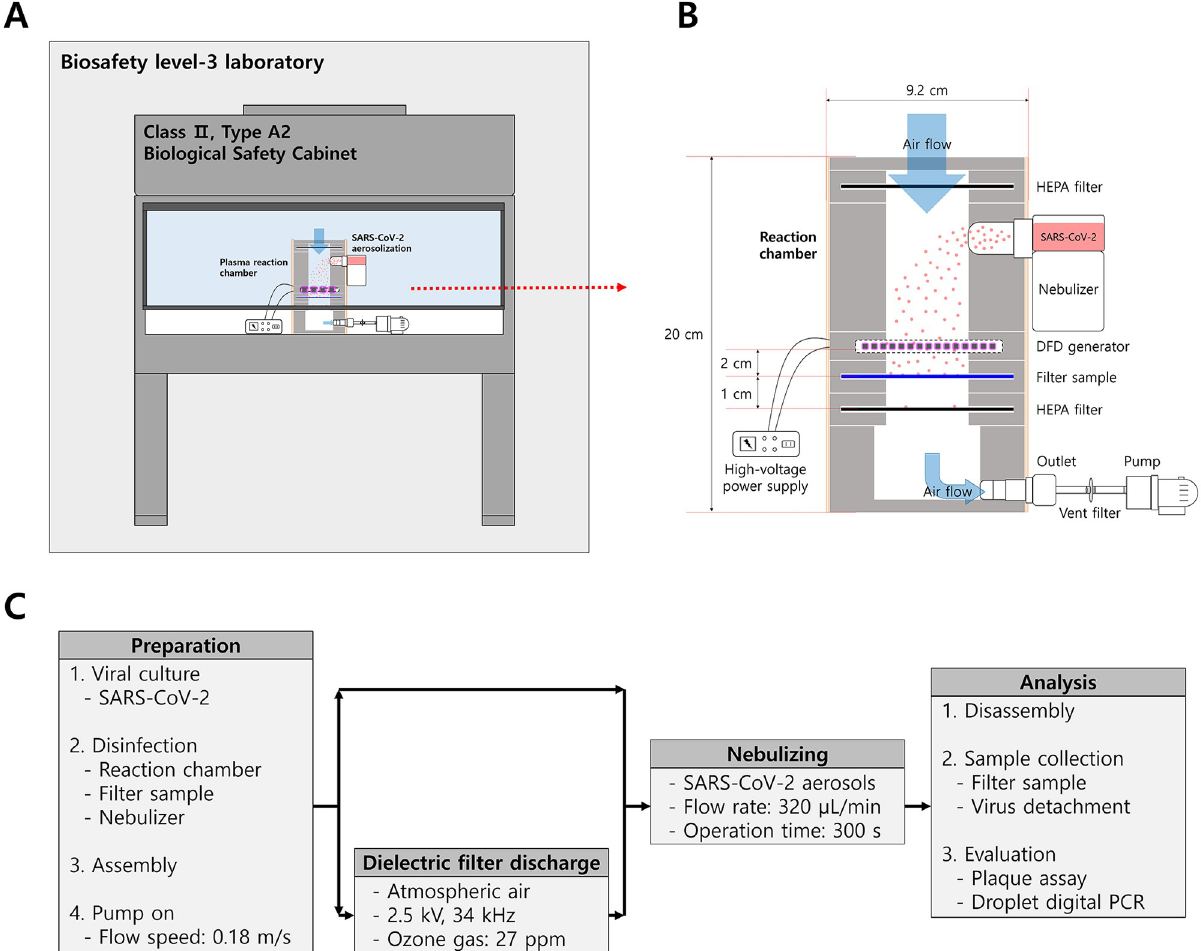
Fig 1. Experimental setup. Schematic diagram (not correctly scaled) of the (A) experimental environment and (B) plasma reaction chamber. (C) Flowchart of the experimental process.